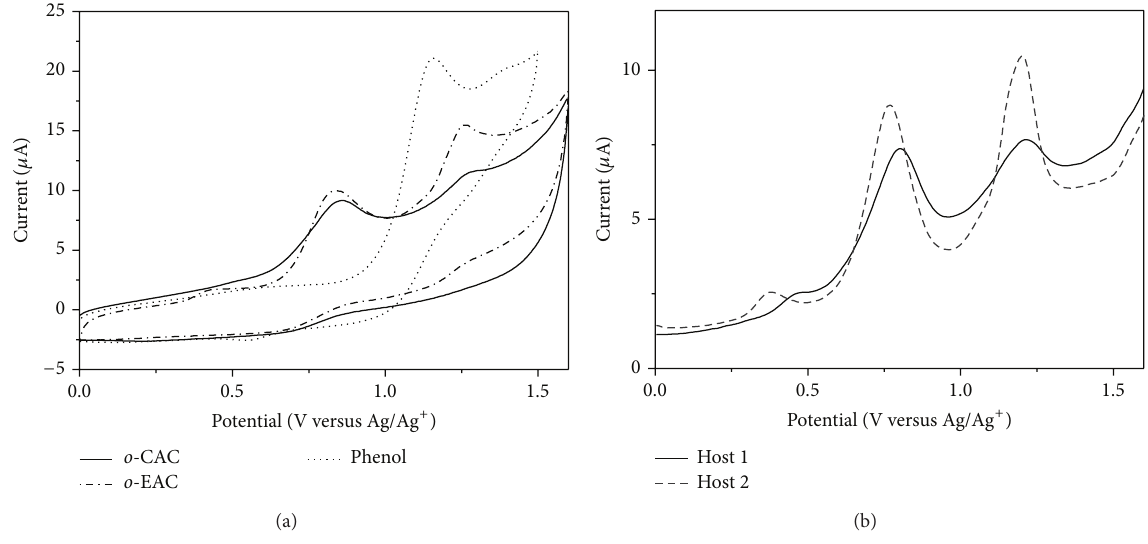
Figure 1: (a) Cyclic voltammograms (CVs) of o -CAC, o -EAC (1 × 10 −4 M), and phenol (5 × 10 −4 M) in 0.1 M TBAPF 6 /CH 3 CN. Scan rate: 50 mV/s. (b) Differential pulse voltammograms (DPVs) of o -CAC and o -EAC (1 × 10 −4 M) in 0.1M TBAPF 6 /CH 3 CN. Pulse amplitude: 50 mV.